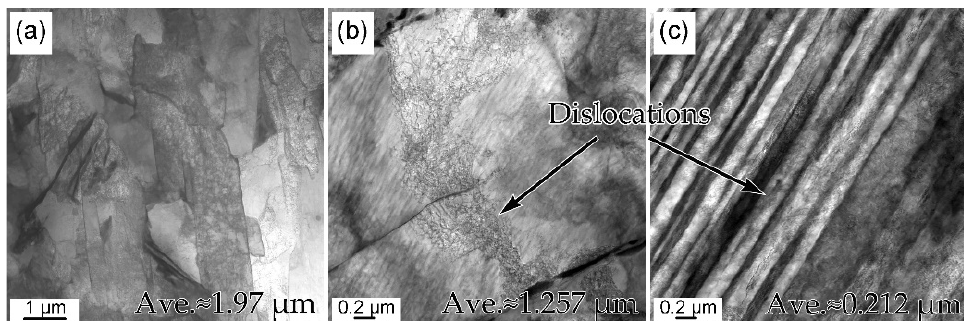
Figure 3. TEM micrographs martensite morphologies of ( a ) quenched, ( b ) cold rolling of specimen CR ‐ 550 ‐ 30, and ( c ) cryorolling of specimen Cryo–R–550–30.